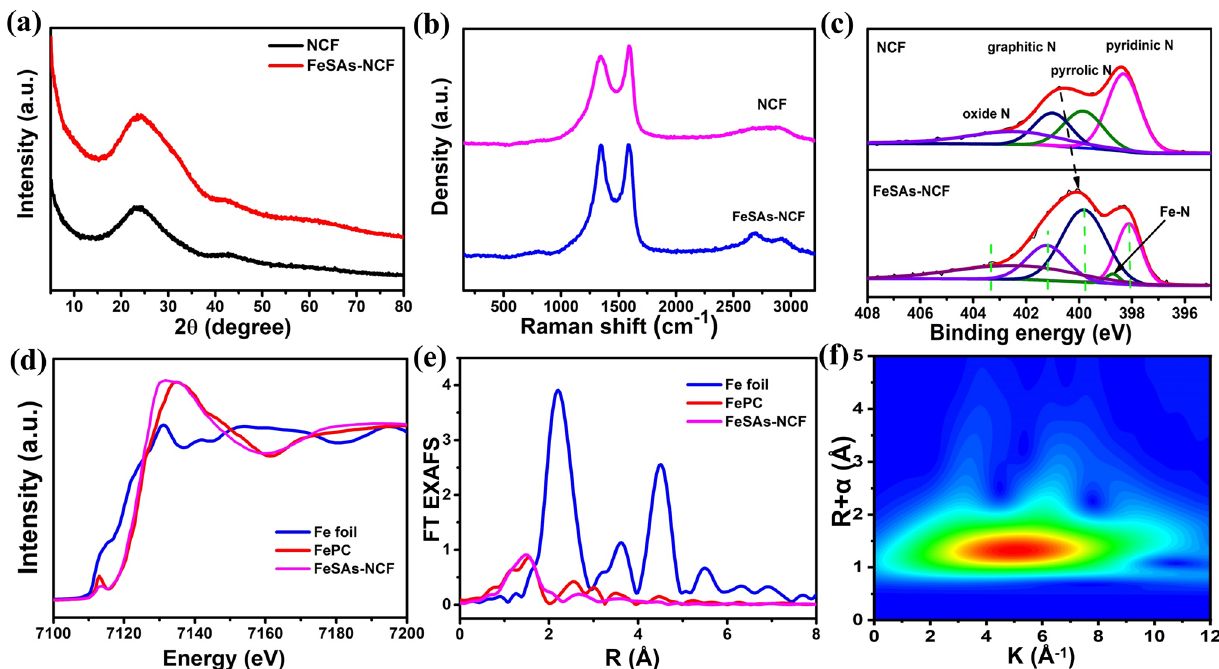
Fig. 2 a XRD patterns, b Raman spectra and c N 1 s XPS of the FeSAs-NCF and NCF. d XANES and e FT EXAFS spectra of the FeSAs-NCF, Fe foil and FePc. f Wavelet transforms of the